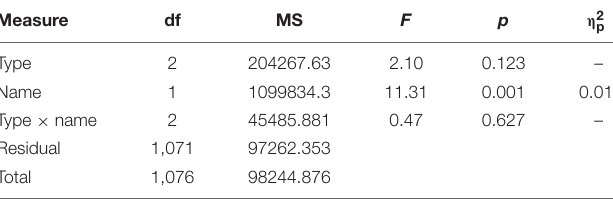
difference test indicated that jdrx894 robot ( M = 540.33), received more money than Michael ( M = 415.95, p = 0.003) in the control